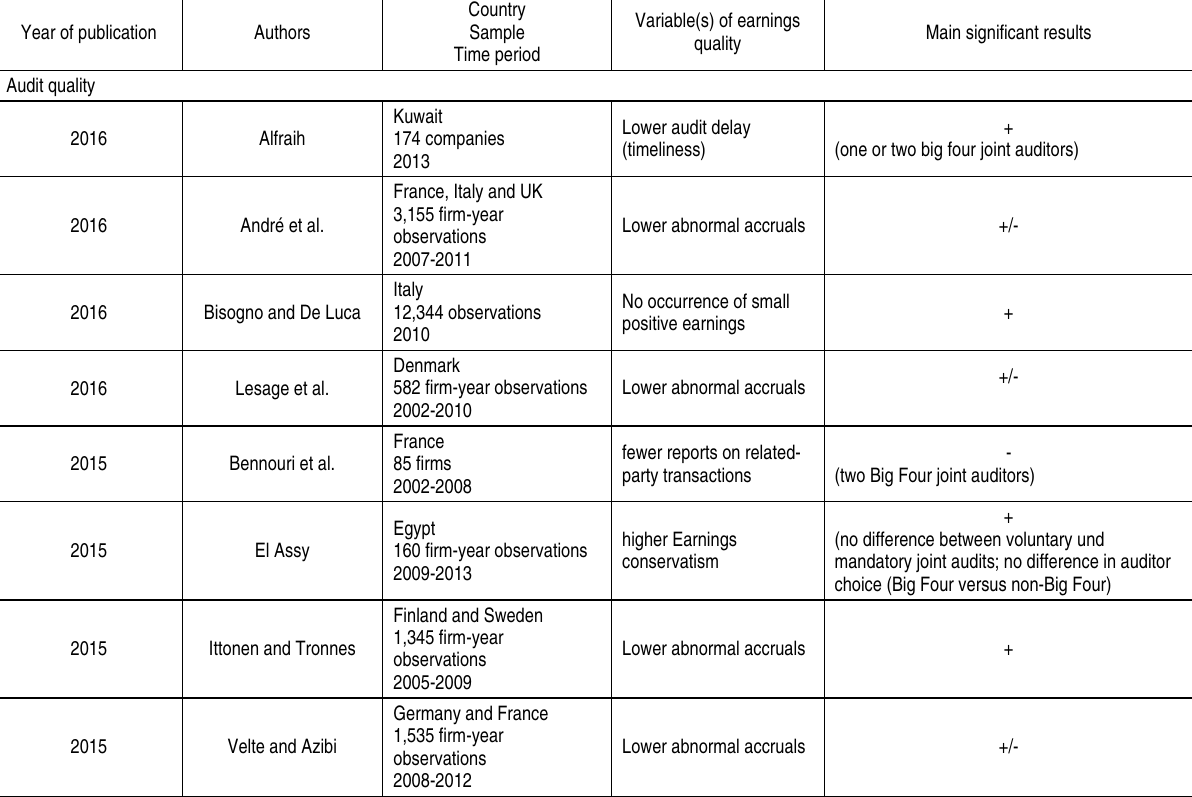
Table 2. Empirical joint audit